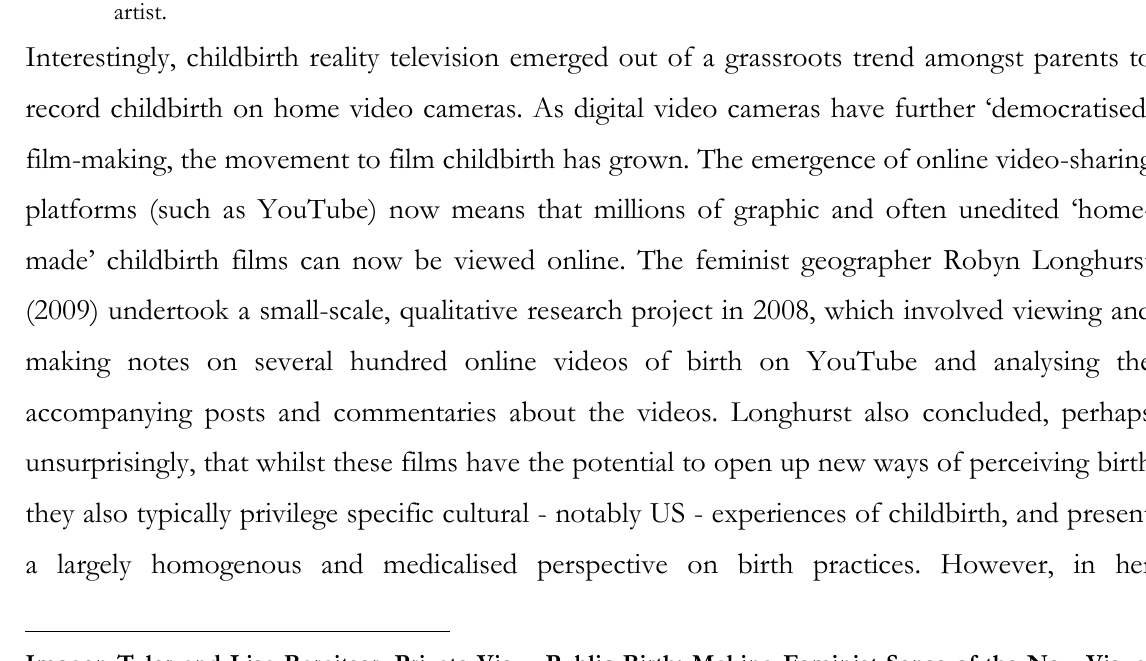
Imogen Tyler and Lisa Baraitser, Private View, Public Birth: Making Feminist Sense of the New Visual Culture of Childbirth Studies in the Maternal , 5 (2), 2013, www.mamsie.bbk.ac.uk